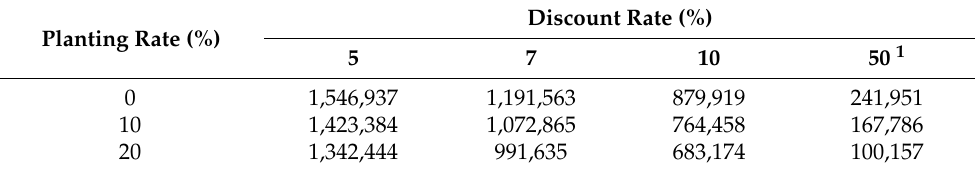
Table 5. Net present value in New Zealand dollars (NZD) at three discount rates (5%, 7%, and 10%) for the sheep enterprise with native shrubs planted on up to 10% of the modelled farm on the steep slopes at 0%, 10%, and 20% planting rates. Discount Rate Planting Rate (%)